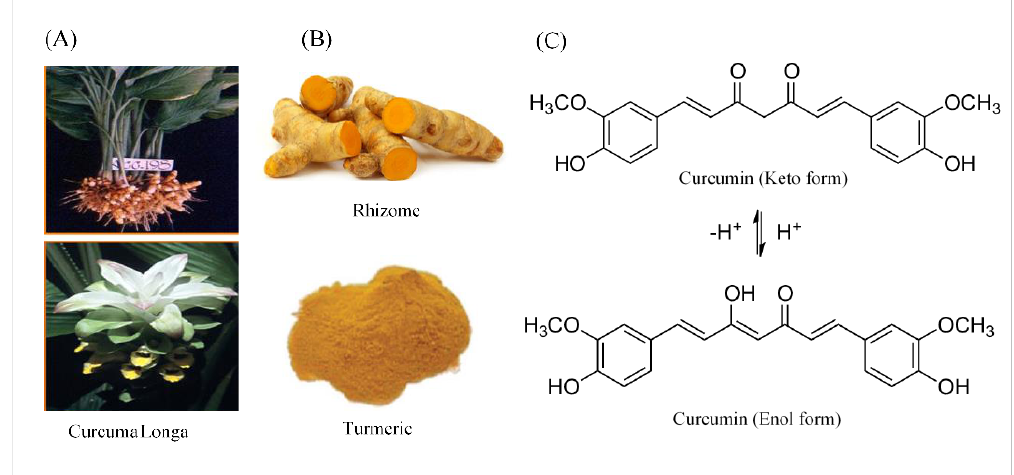
Figure 1. The source, crude form, and chemical structure of curcumin. ( A ) The botanic source of turmeric. ( B ) Crystallized powder of curcumin. ( C ) The enol and keto forms of curcumin.